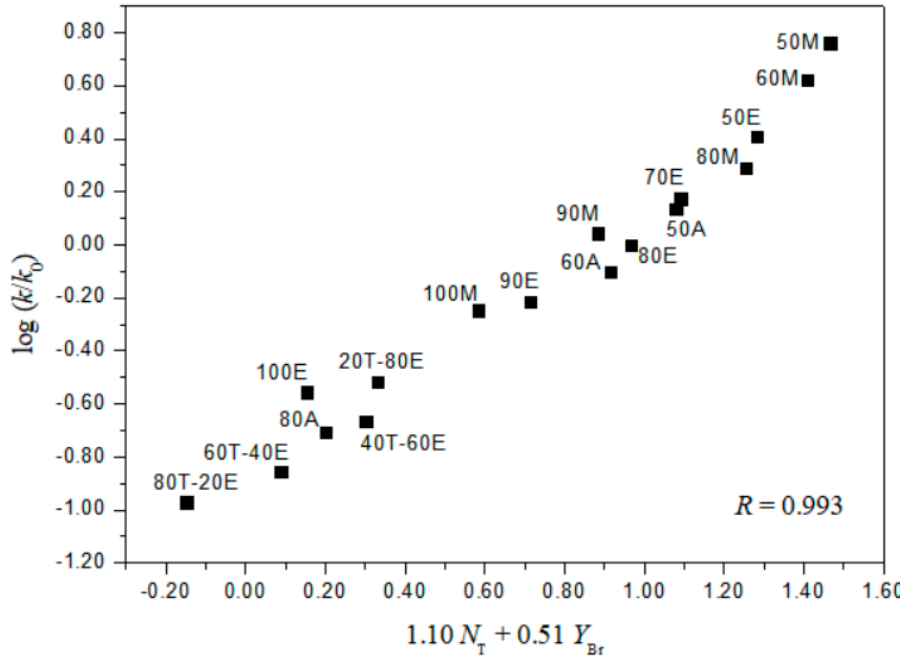
Figure 2. The plot of log ( k/k o ) o vs. 1.10 N T + 0.51 Y Br for the solvolysis of o ‐ nitrobenzyl bromide ( 1 ) in various organic solvents at 45.0 °C.